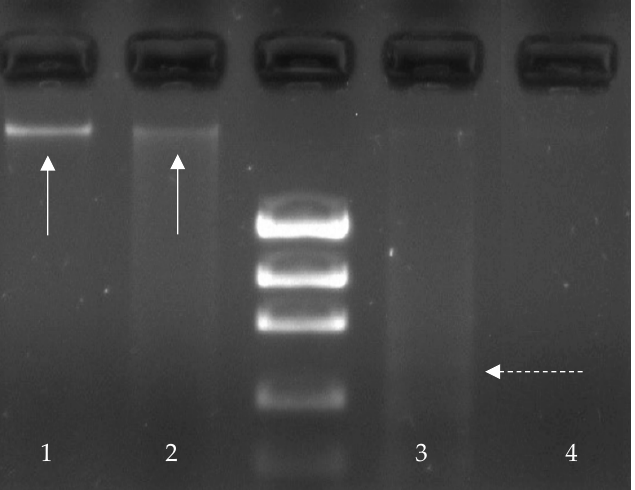
Figure 1. Samples scoring 1 to 4 for the different degrees of DNA degradation found in our study. Arrows shows genomic DNA, and broken arrow shows smear which indicates DNA degradation.